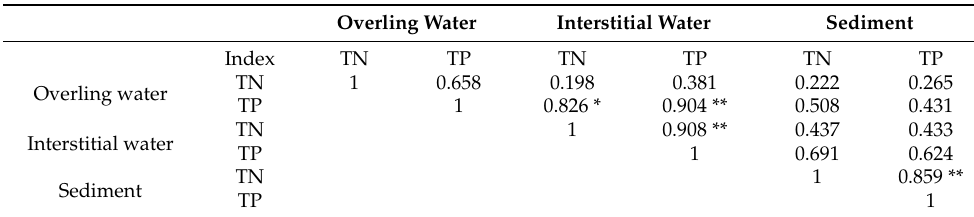
Table 4. Correlation analysis of nitrogen and phosphorus in overlying water, interstitial water, and sediment of the Yitong River.